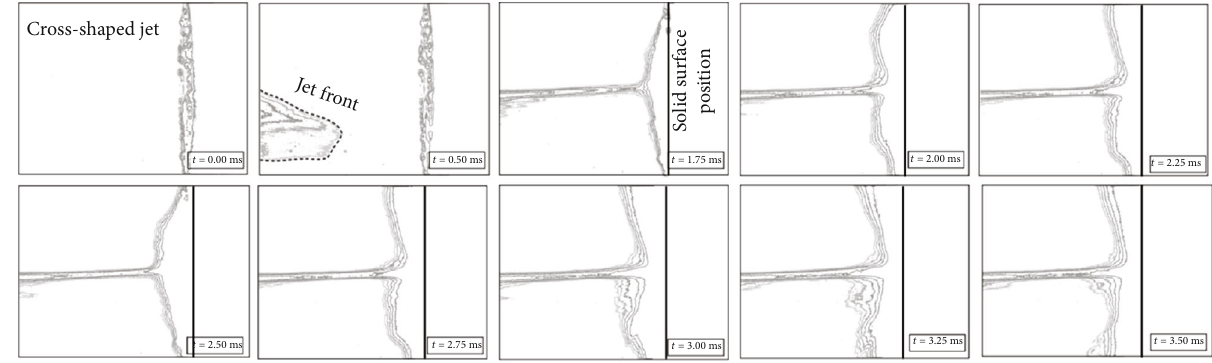
Figure 9: The evolutions of a cross-shaped jet impacting a solid surface.